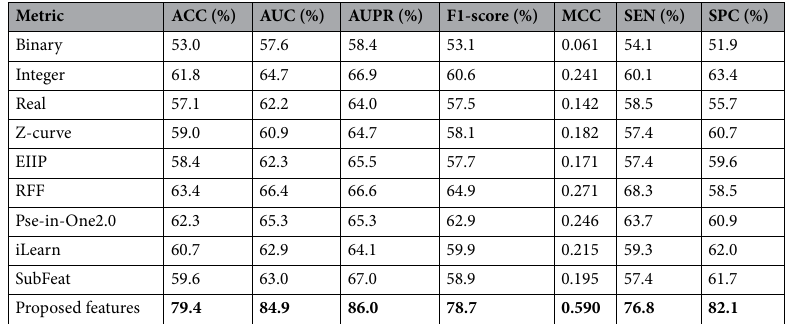
Table 6. The performance evaluation of the proposed features based on PyFeat with AB compared with other techniques: five numerical representations, RFF, Pse-in-One2.0, iLearn, and SubFeat with 10-fold cross- validation based on the protein dataset. Significant values are in bold.